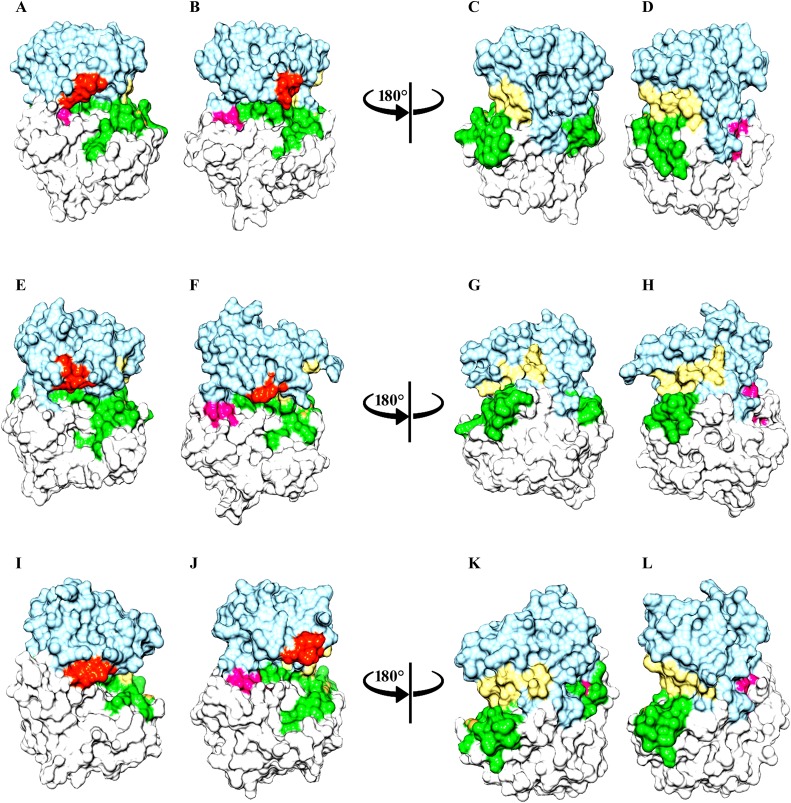
Comparative surface view analysis of group-II PAKs on the basis of MD simulation.Surface view of (A and B) PAK4 and PAK4Sep474, (C and D) inactive and active PAK4, rotated at 180°, (E and F) PAK5 and PAK5Sep602, (G and H) inactive and active PAK5, rotated at 180°, (I and J) PAK6 and PAK6Sep560, (K and L) inactive and active PAK6, rotated at 180°. Color codes are given in the Fig 4 legend.